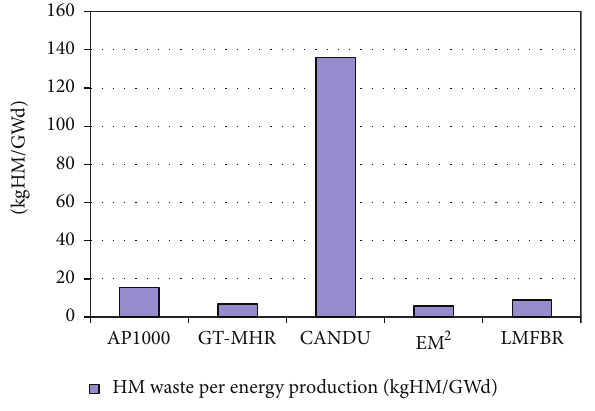
Figure 10: Comparison of waste per energy production.